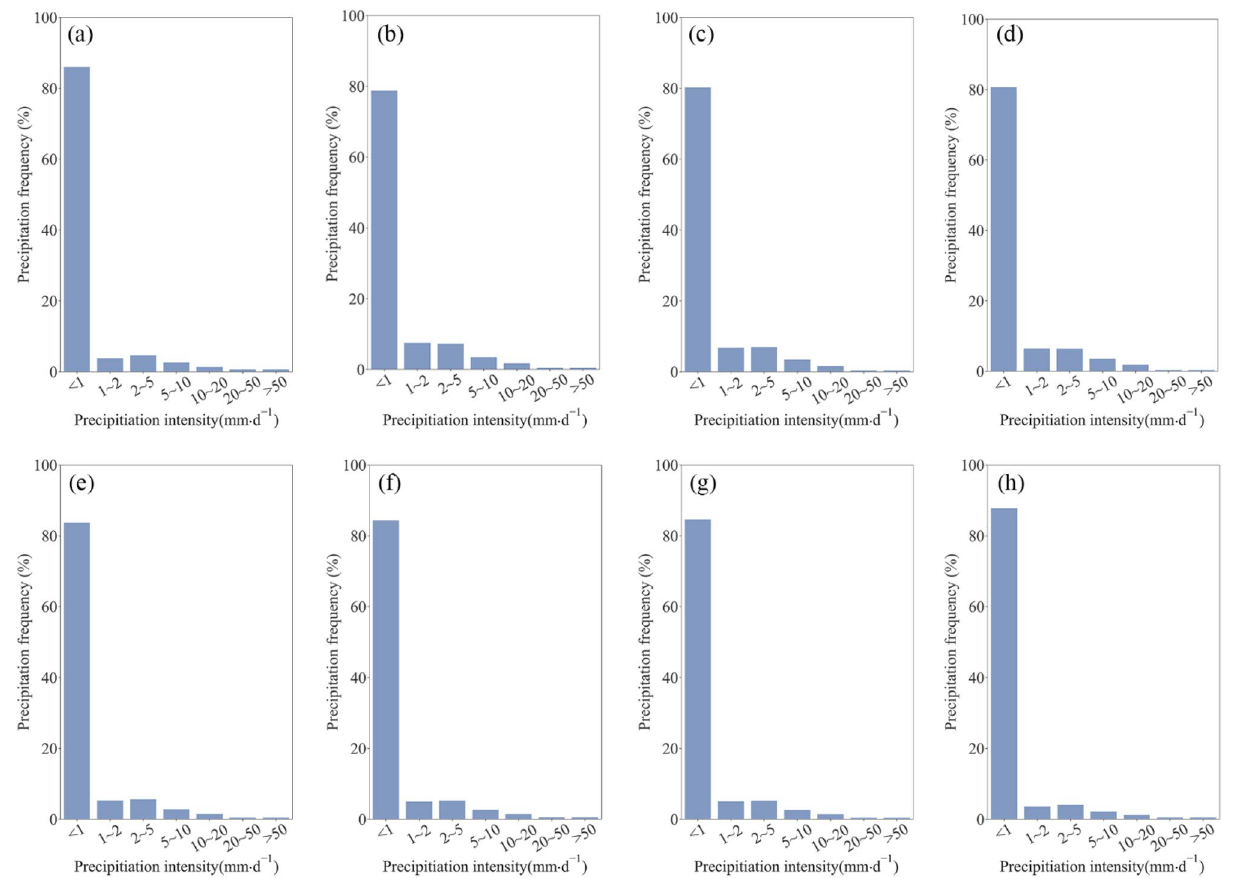
Figure 6. Frequency of different precipitation intensities obtained by ( a ) ground-based stations, ( b ) ERA5- Land, ( c ) ERA5-HRES, ( d ) ERA-Interim, ( e ) IMERG ER, ( f ) IMERG LR, ( g ) IMERG FR, and ( h ) TMPA-3B42.